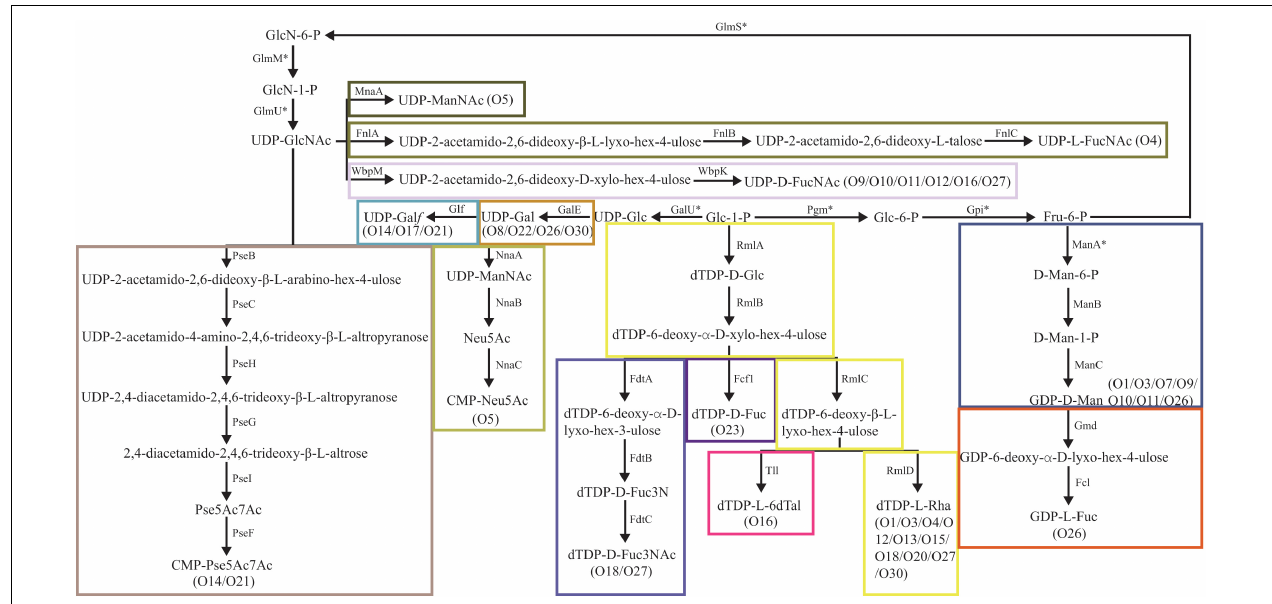
FIGURE 2 | Biosynthesis pathways for the putative sugars in the E. cloacae O-antigens. MnaA, UDP-N-acetylglucosamine-2-epimerase (Campbell et al., 2000); FnlA, 4,6-dehydratase, 3- and 5-epimerase; FnlB, reductase; FnlC, C-2 epimerase (Kneidinger et al., 2003); GalE, UDP-glucose-4-epimerase (Samuel and Reeves, 2003); Glf, UDP-galactopyranose mutase (Nassau et al., 1996); GalU, UTP-glucose-1-phosphate uridylyltransferase (Bonofiglio et al., 2005); GlmU, UDP-N-acetyl-glucosamine pyrophosphorylase (Mengin-Lecreulx and van Heijenoort, 1993); GlmM, phosphoglucosamine mutase (Mengin-Lecreulx and van Heijenoort, 1996); GlmS, L-Glutamine:D-fructose-6-phosphate amidotransferase (Badet et al., 1987); Pgm, phosphoglucomutase (Lu and Kleckner, 1994); Gpi, Glucose-6-phosphate isomerase (Winkler, 1970); NnaA, UDP-N-acetylglucosamine-2-epimerase; NnaB, N-acetylneuraminic acid synthetase; NnaC, CMP-N-acetylneuraminic acid synthetase (Annunziato et al., 1995); RmlA, glucose-1-phosphate thymidylyltransferase (Zuccotti et al., 2001); RmlB, dTDP- D -glucose 4,6-dehydratase (Allard et al., 2001); RmlC, dTDP-4-keto-6-deoxy- D -glucose 3,5-epimerase (Giraud et al., 1999a); RmlD, dTDP-6-deoxy-L-mannose-dehydrogenase (Giraud et al., 1999b); ManA, phosphomannose isomerase; ManB, phosphomannomutase; ManC, mannose-1-phosphate guanylyltransferase (Samuel and Reeves, 2003); Gmd, GDP-mannose-4,6-dehydratase (Somoza et al., 2000; Kneidinger et al., 2001); Fcl, GDP-L-fucose synthetase (Rosano et al., 2000); FdtA, dTDP-6-deoxy-hex-4-ulose isomerase; FdtB, dTDP-6-deoxy- D -xylo-hex-3-ulose aminase; FdtC, dTDP- D -Fuc3N acetylase (Pfoestl et al., 2003); WbpM, UDP-D-GlcNAc 4,6-dehydratase; WbpK, 4-reductase (King et al., 2009); PseB, C6 dehydratase/C5 epimerase; PseC, aminotransferase; PseH, N-acetyltransferase; PseG, nucleotidase; PseI, condensase; PseF, cytidylyltransferase (Schoenhofen et al., 2006); Fcf1, dTDP-6-deoxy-D-xylo-hex-4-ulopyranose reductase (Wang et al., 2008); Tll, dTDP-6-deoxy-L-lyxo-4-hexulose reductase (Nakano et al.,